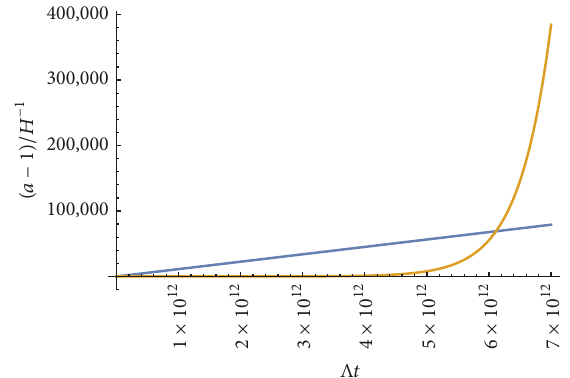
Figure 6: Scale factors when time is large. The blue curve is for our toymodel,andtheorangeoneisforstandardscenario.LikeFigure5, the vertical axis is also